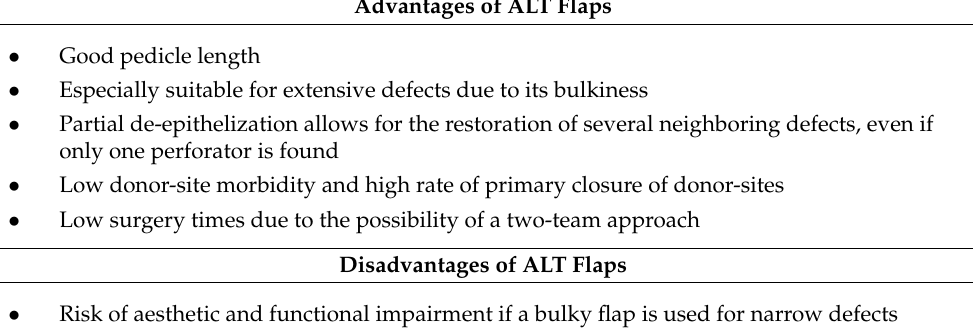
Table 4. Considerations regarding the ALT flap as reconstructive technique of choice for full-thickness defects of the head and neck